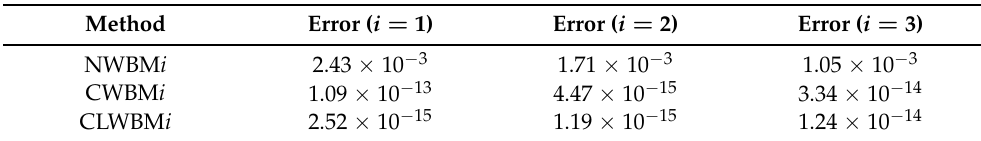
Table 8. Test 2.2. Differences in L 1 -norm with respect to the stationary solution for NWBM i , CWBM i , and CLWBM i ( i = 1,2,3) at time t = 5